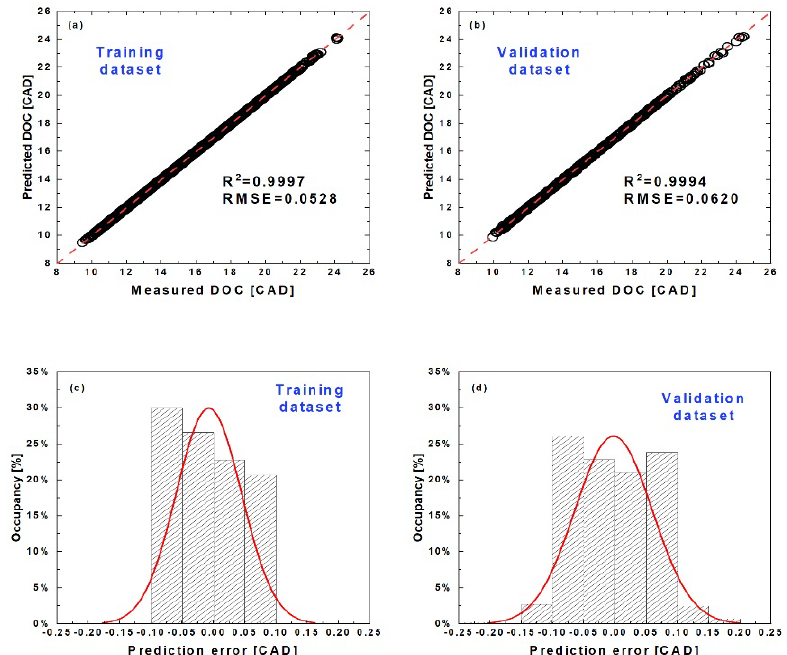
Figure 10. Comparison of predicted DOC with the measured data. ( a ) Prediction performance of training dataset; ( b ) prediction performance of validation dataset; ( c ) prediction error of training dataset; and ( d ) prediction error of validation.